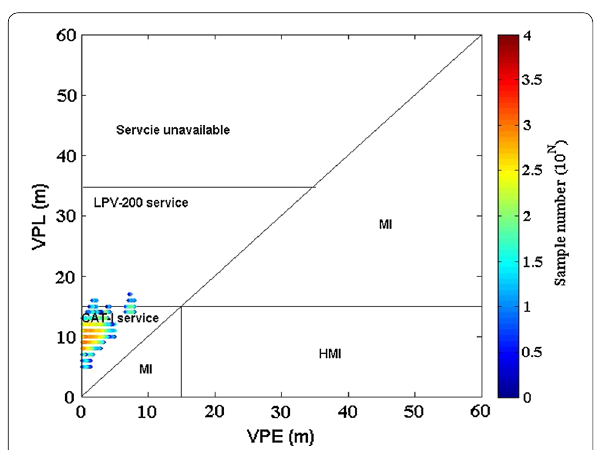
Fig. 6 Vertical performance of SXTY